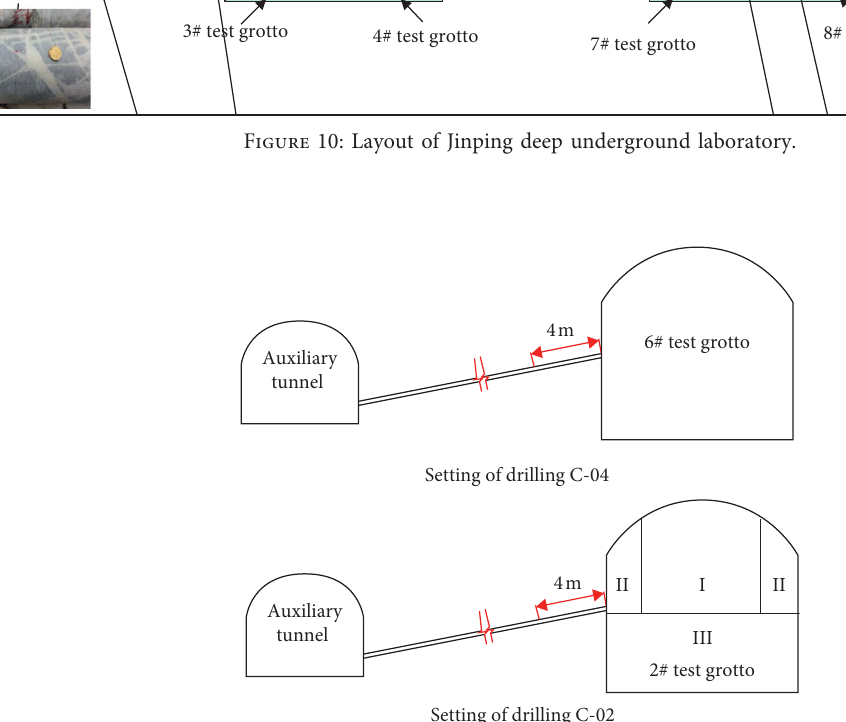
Figure 11: Layout of C-02 and